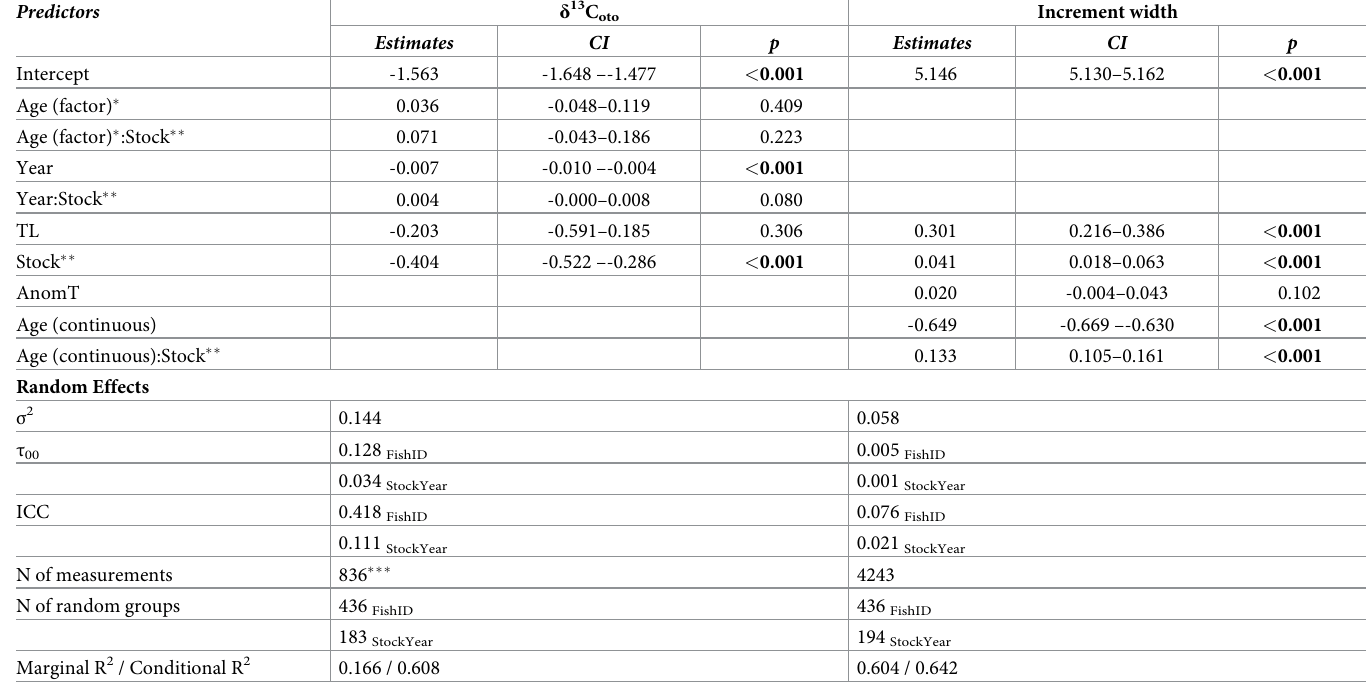
Table 2. Parameter estimates of the optimal univariate models for otolith carbon isotope ratios and increment width selected with AICc. Estimates are given for all fixed effects with confidence intervals ( CI ) and significance ( p ). For the random effects residual variance ( σ 2 ), the variance associated with tested effects ( τ 00 ) and their intraclass correlation coefficient ( ICC ) are given. The number of observations used to fit model and the amount of variance explained ( marginal and conditional R 2 ) are specified.